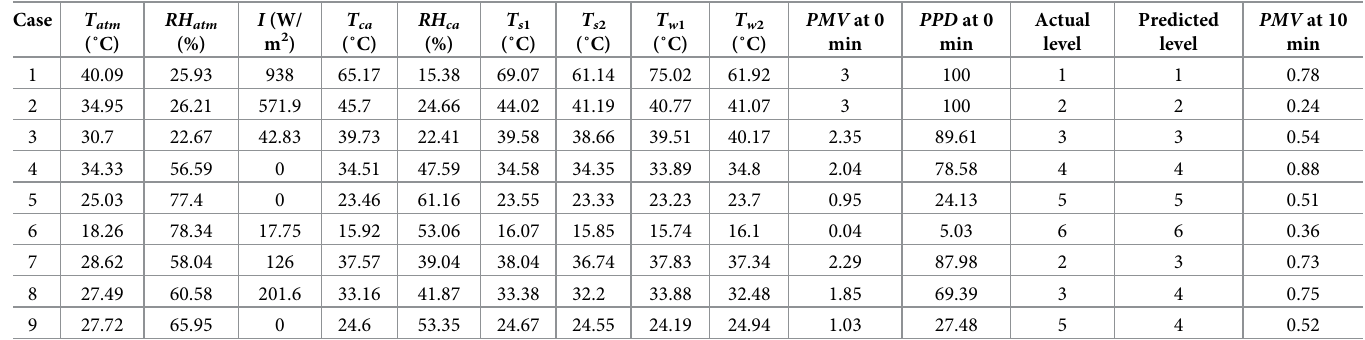
Table 5. Case study for pre-conditioning analysis.